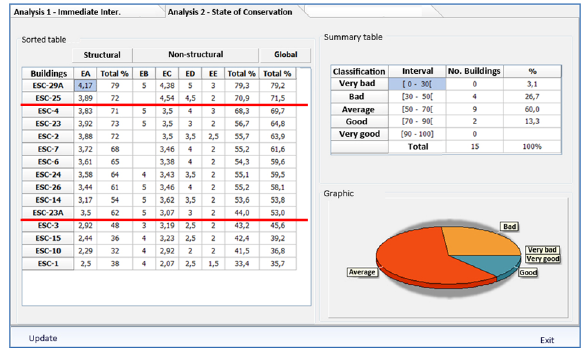
Figure 5: ICT platform application for evaluation of status of wooden stilt-houses conservation, in